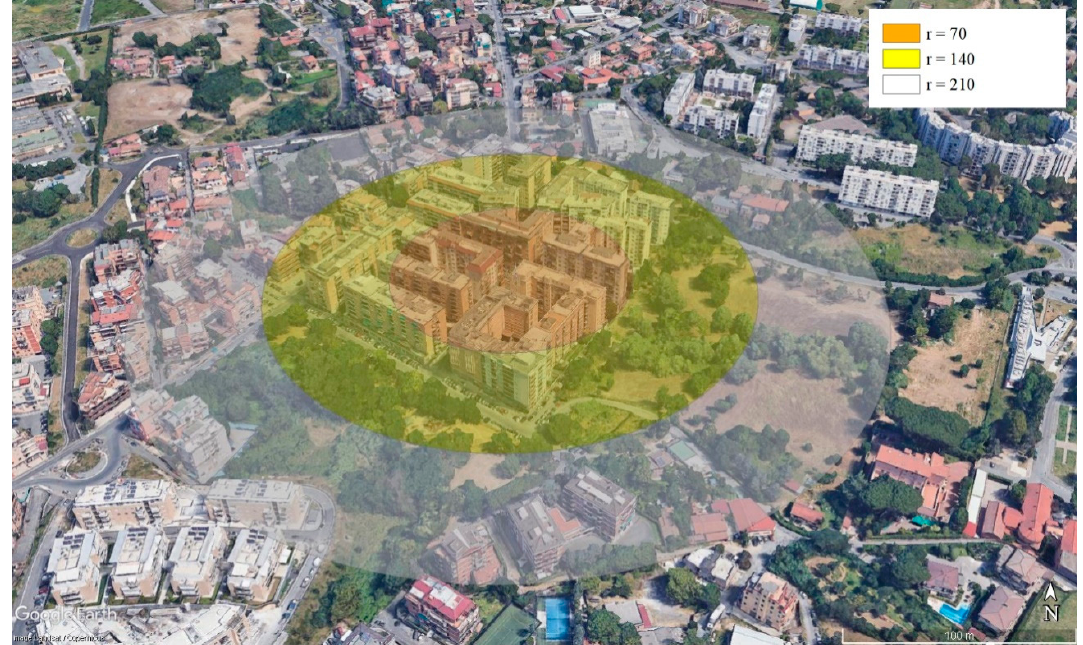
Figure 6. Prime three-dimensional model concerning the circular buffer zones defined by the imposing high antenna (the same as in Figure 4) in a GIS environment. Source: authors’ elaboration.